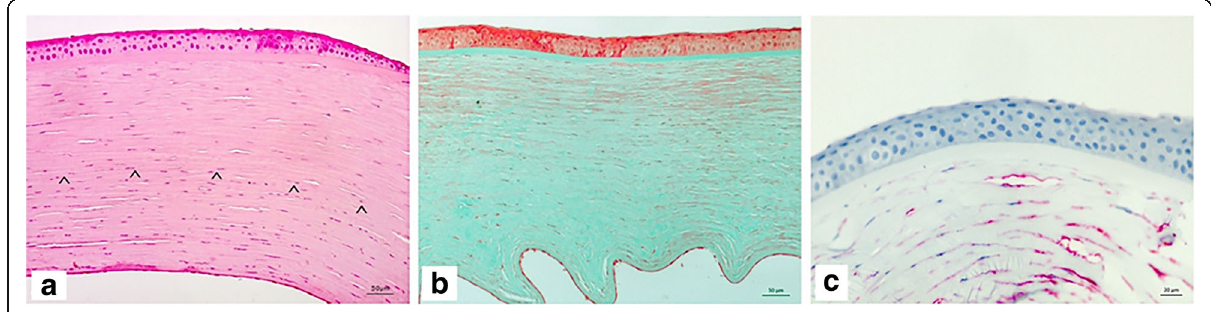
posterior part (arrowheads) (haematoxylin-eosin, × 20). b Masson-Goldner stain shows increase of irregular collagen bundles in the middle